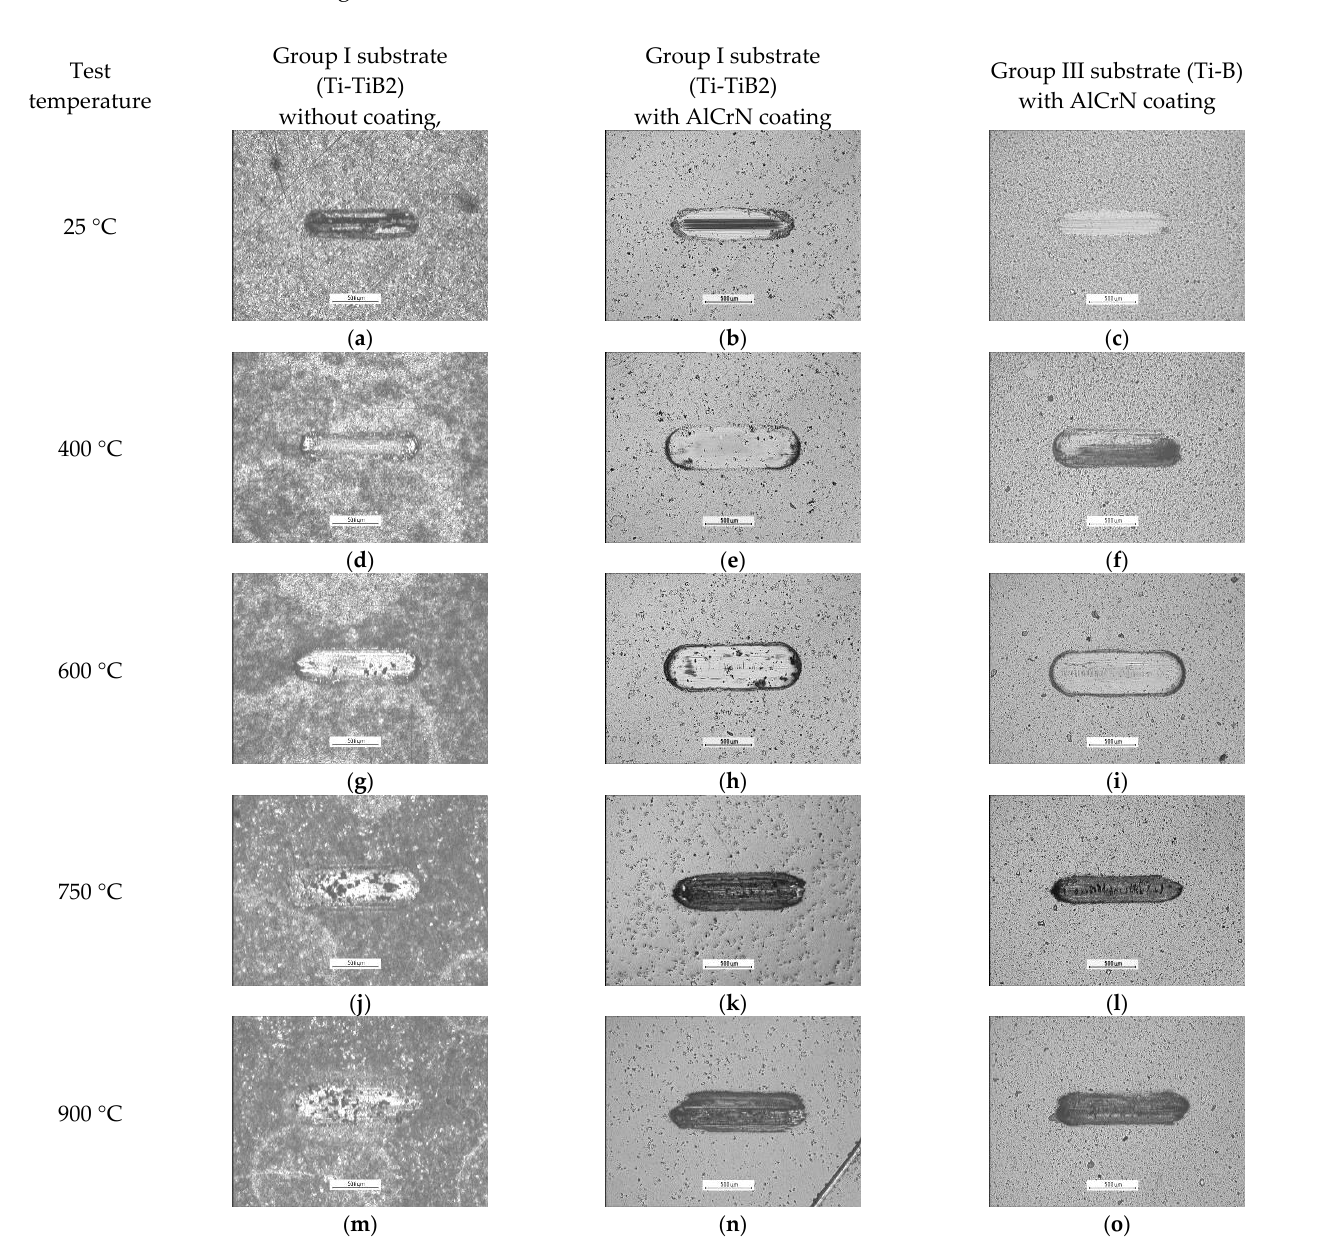
Figure 8. Evolution of the coating failure during the wear test (optical microscopy, scale bars show 500 µ m for disc samples): ( a ) temp. 25 ◦ C, Group I disc-uncoated; ( b ) temp. 25 ◦ C, Group I disc with AlCrN; ( c ) temp. 25 ◦ C, Group III disc with AlCrN; ( d ) temp. 400 ◦ C, Group I disc-uncoated; ( e ) temp. 400 ◦ C, Group I disc with AlCrN; ( f ) temp. 400 ◦ C, Group III disc with AlCrN; ( g ) temp. 600 ◦ C, Group I disc-uncoated; ( h ) temp. 600 ◦ C, Group I disc with AlCrN; ( i ) temp. 600 ◦ C, Group III disc with AlCrN; ( j ) temp. 750 ◦ C, Group I disc-uncoated; ( k ) temp. 750 ◦ C, Group I disc with AlCrN; ( l ) temp. 750 ◦ C, Group III disc with AlCrN; ( m ) temp. 900 ◦ C, Group I disc-uncoated; ( n ) temp. 900 ◦ C, Group I disc with AlCrN; ( o ) temp. 900 ◦ C, Group III disc with